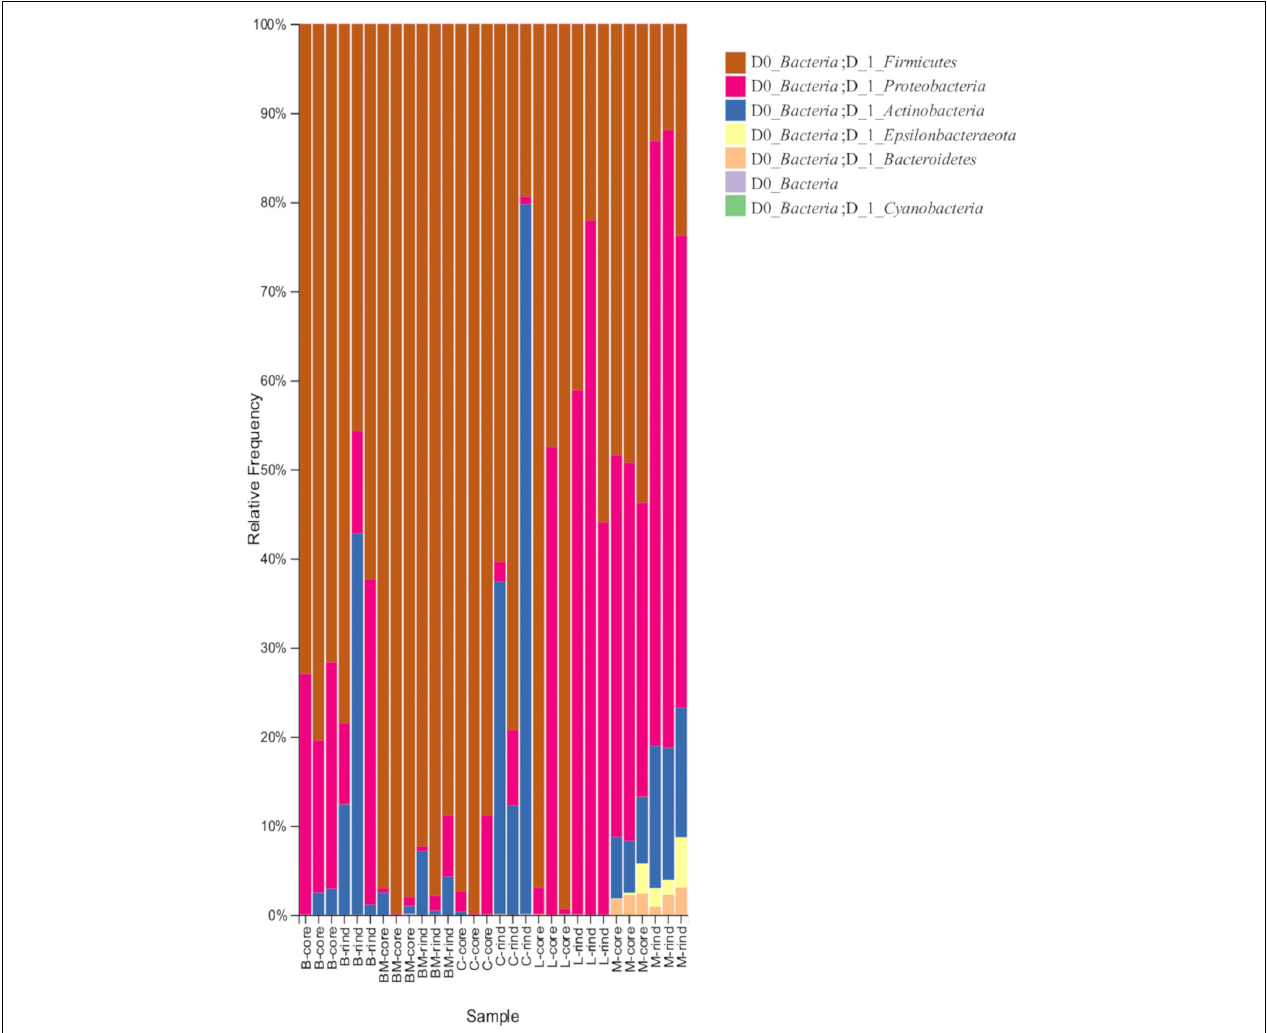
FIGURE 1 | Relative abundance of bacteria phylum in 30 cheese samples. B, Brie de Meaux; BM, Brie de Melun; C, Coulommiers; L, Langres; M, Maroilles.